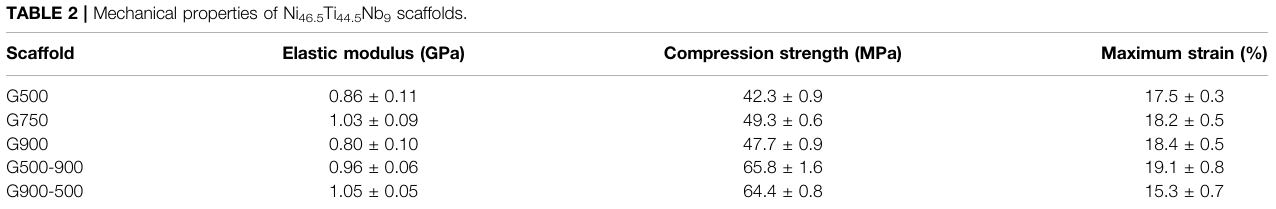
TABLE 2 | Mechanical properties of Ni 46.5 Ti 44.5 Nb 9 scaffolds.